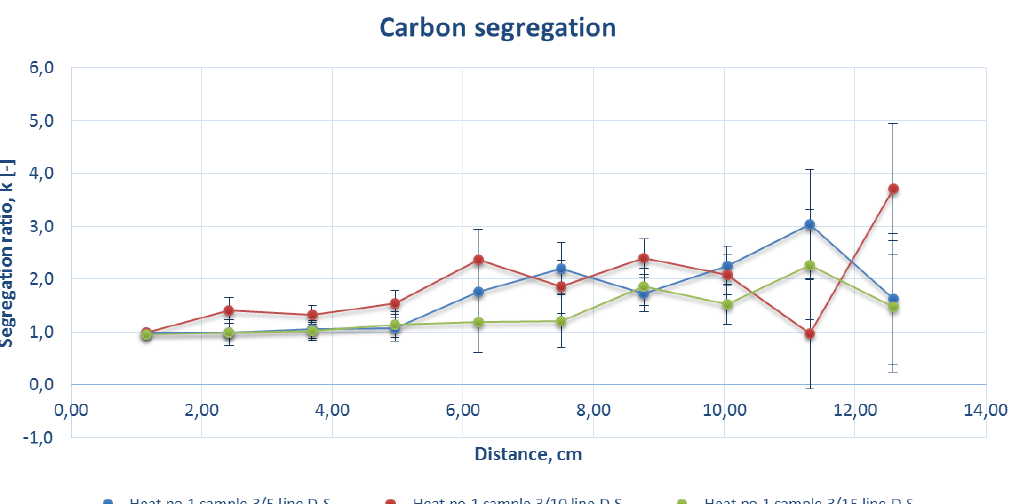
Figure 7. Comparison of the carbon segregation ratio for the sample DS line of strand 1 at a casting speed of 1.8 m/min (heat number 1).